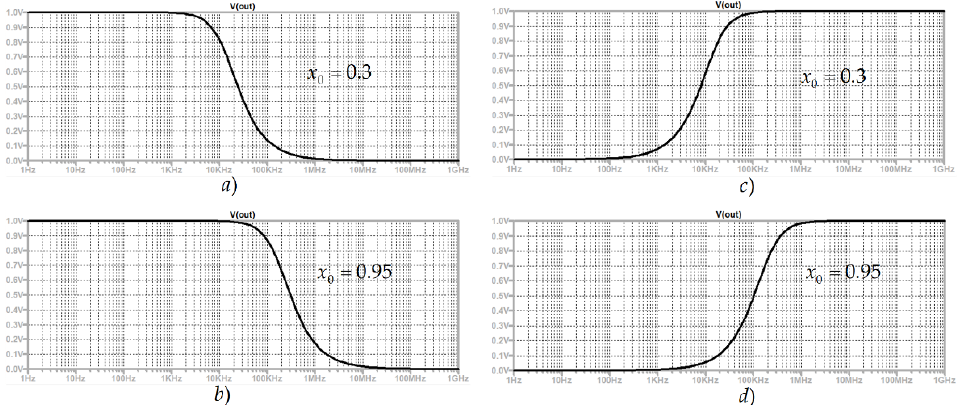
Figure 15. ( a ) Amplitude-frequency response (AFR) of a low-pass filter for x 0 =0.3: ( b ) AFR of a low-pass filter for x 0 =0.95; ( c ) AFR for the high-pass filter for x 0 =0.3; ( d ) AFR for the high-pass filter for x 0 =0.95. By increasing the state variable, the respective memristance decreases, and the corresponding cut-off frequency increases. The change in the state variable in the range from zero to unity ensures the alteration of the cut-off frequency from 9.95 kHz to 1.59 MHz. In Figure 16, band-pass and band-stop memristor filters are presented for an explanation of their structure and functioning.